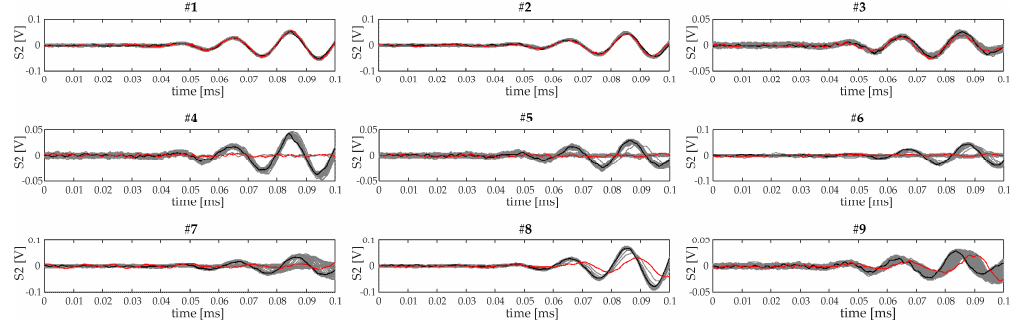
Figure 10. Wave propagation signals registered during monitoring of steel-concrete push-out specimens ( #1 – #9 ); the first signal (reference) is given in black, the last registered signal in given in red, all other signals are given in grey.